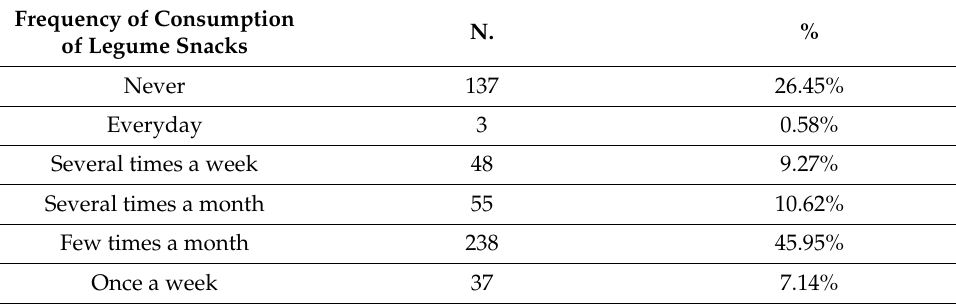
Table A6. Frequency of consumption of legume-based snack (in % of